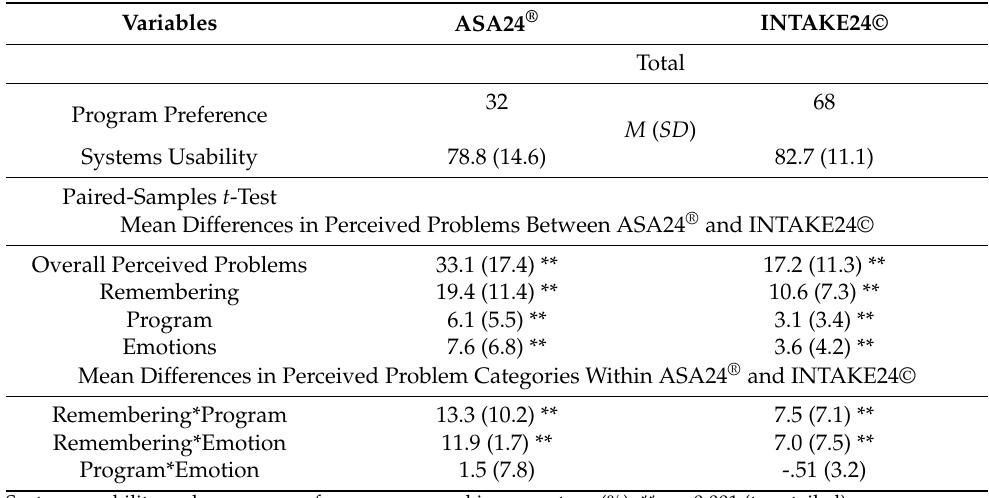
Table 4. Program Preference (%) and Results of Paired-Samples t-Test, including Means ( M ), Standard Deviations ( SD ), and Significance Values ( p ) for the Differences Within and Between Problem Cate- gories (Remembering, Program, and Emotion) and Systems Usability for ASA24 ® and INTAKE24© ( N =